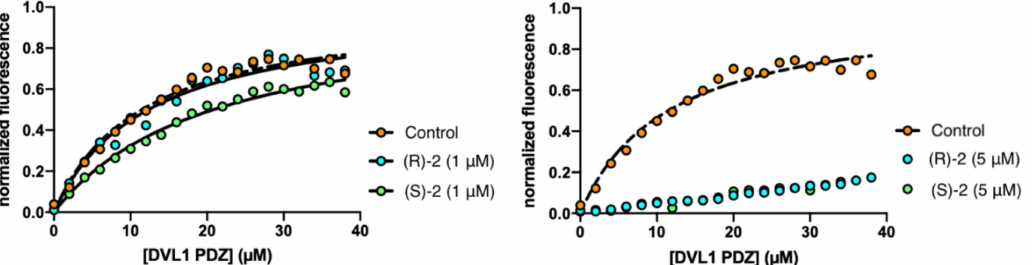
Figure 3. Equilibrium binding experiment between PDZ domain of DVL1 and the C-terminal portion of TMEM88 in the absence and presence of ( S )- 1 or ( R )- 1 at 1 µ M ( right panel) and 5 µ M ( left panel). Lines are the best fit for a hyperbolic function.